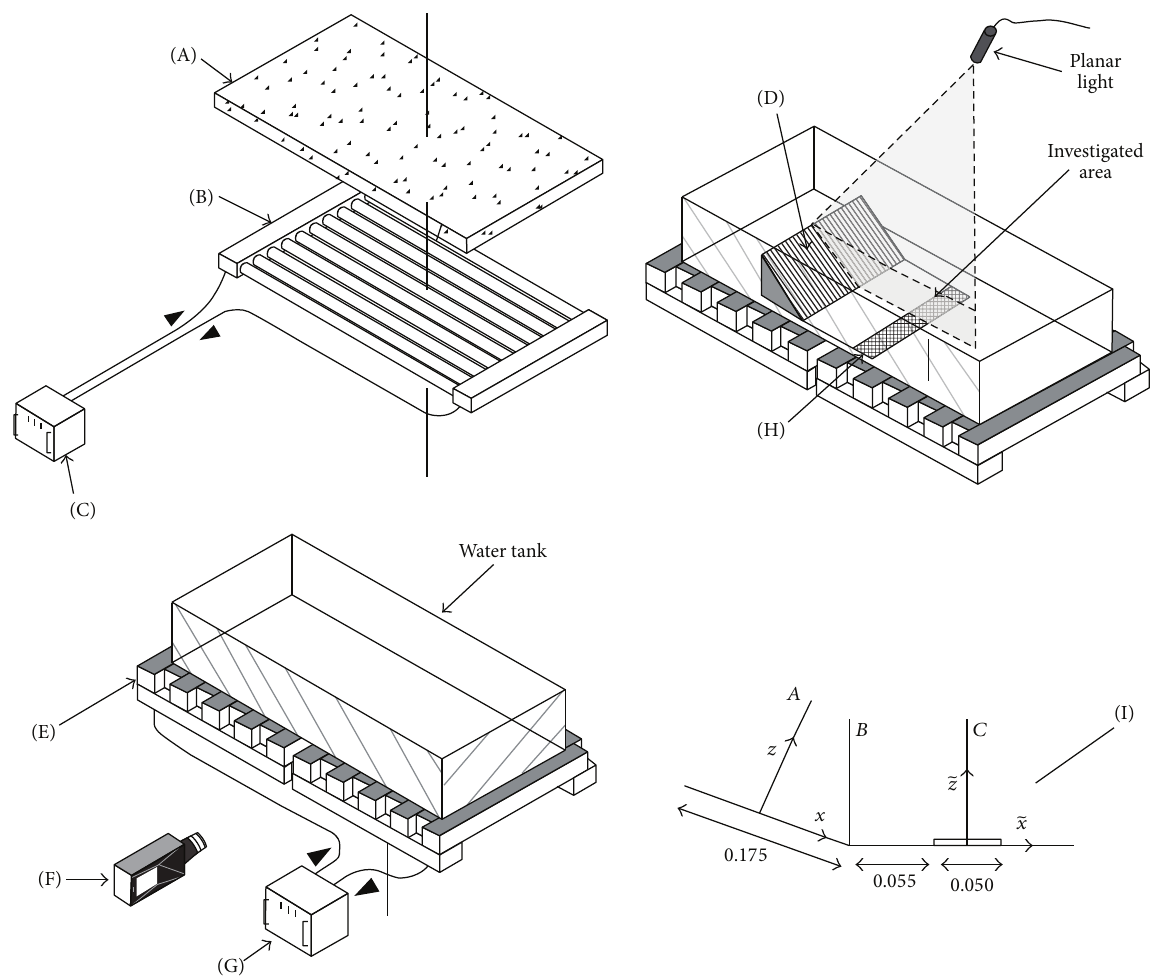
Figure 18: Experimental apparatus: (A) polystyrene sheet, (B) free surface heat exchanger, (C) free surface thermostat, (D) valley model, (E) bottom surface heat exchanger, (F) camera, (G) bottom surface thermostat, (H) rectangular-shaped electric heater, and (I) reference systems and locations of temperature arrays velocity profiles (units are in